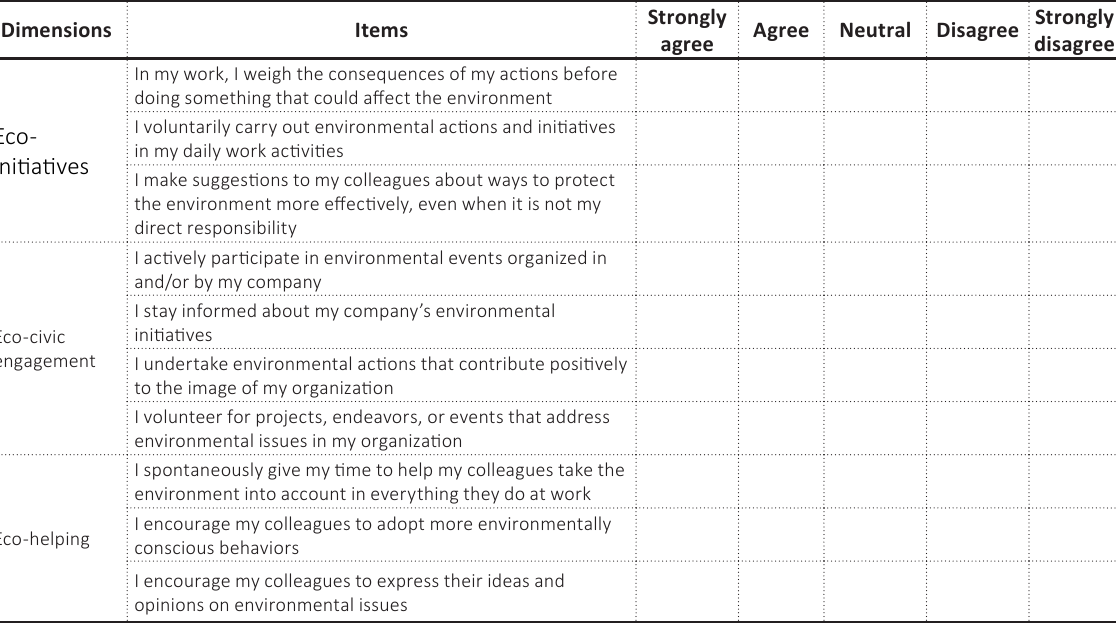
Dimensions Items